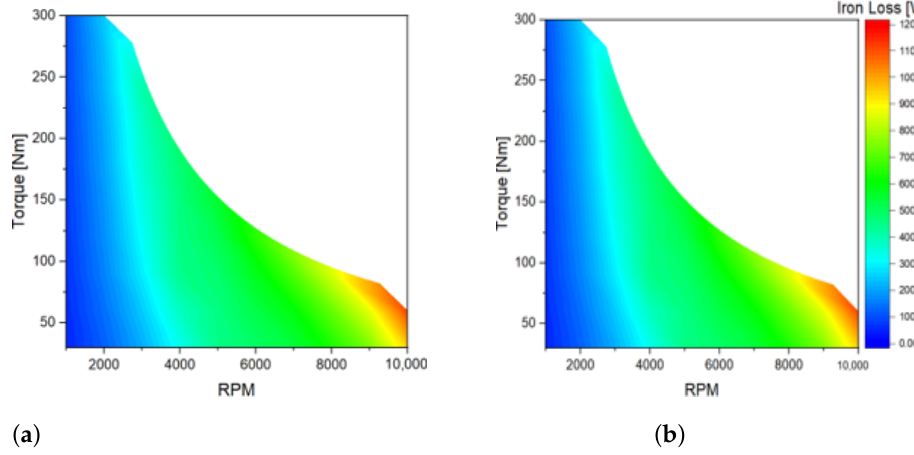
Figure 18. Iron loss maps: ( a ) conventional method. ( b ) proposed